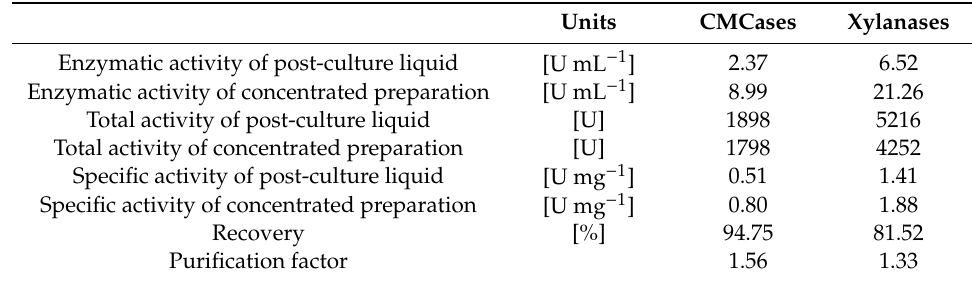
Table 1. Enzyme yields and purification factors after ultrafiltration